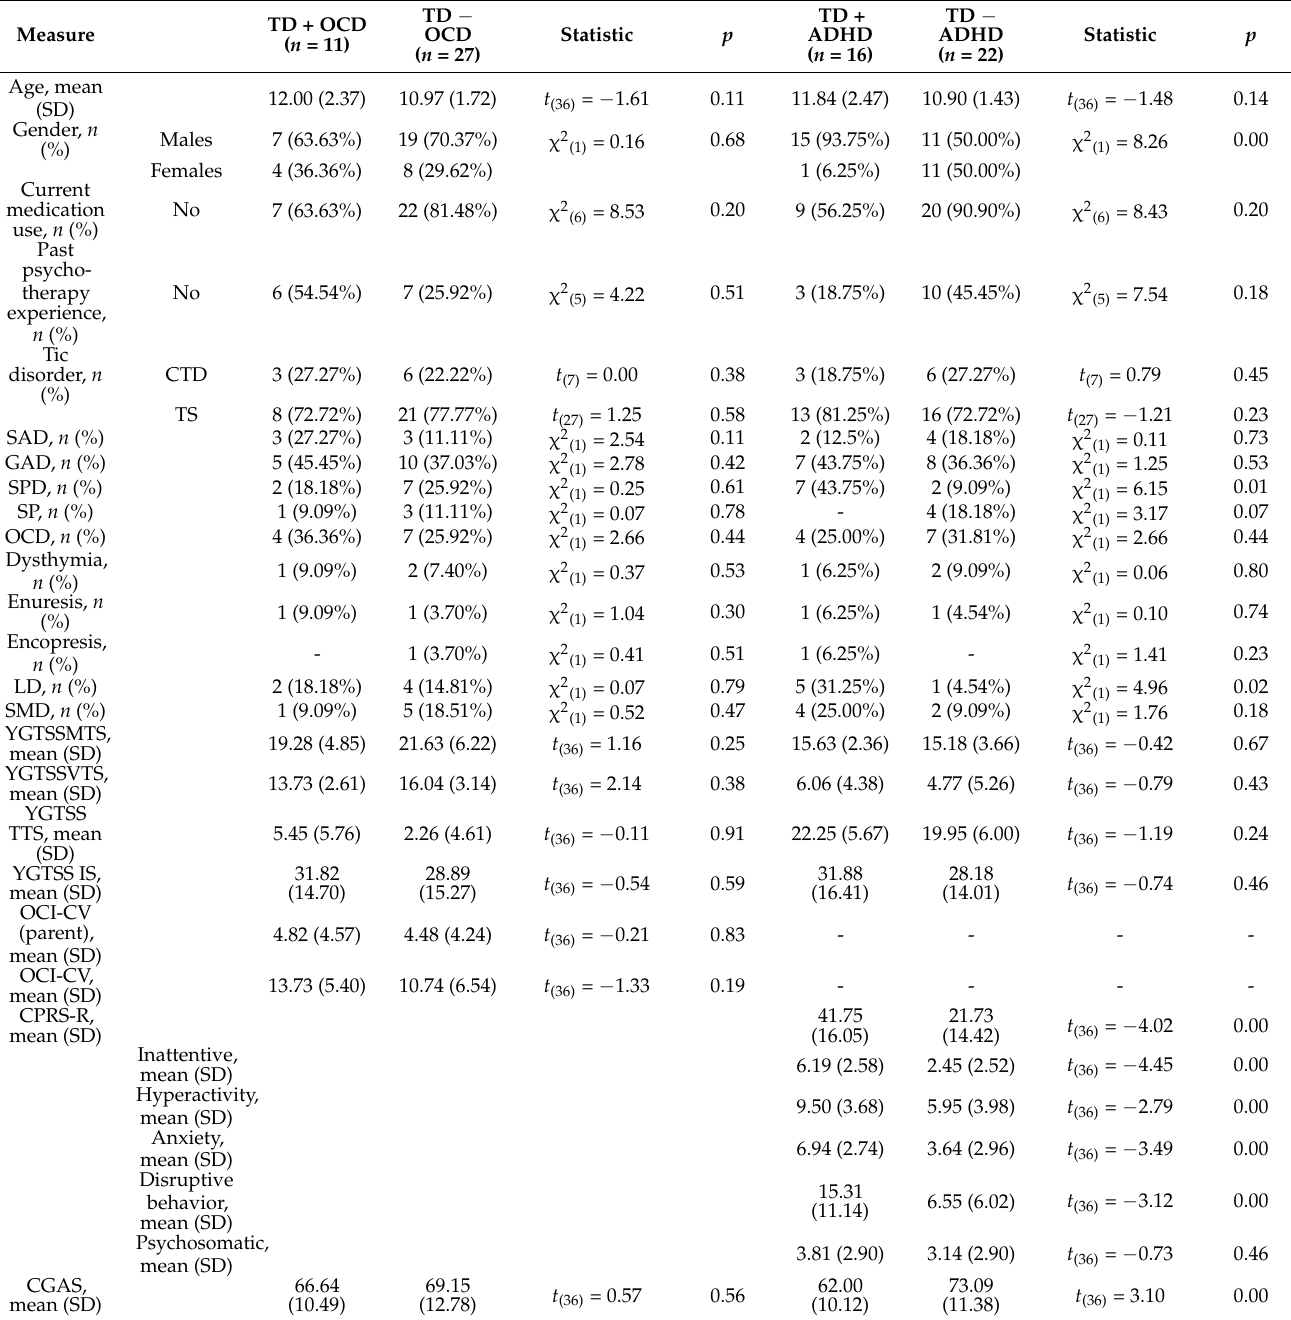
Table 1. Baseline Demographic and Clinical